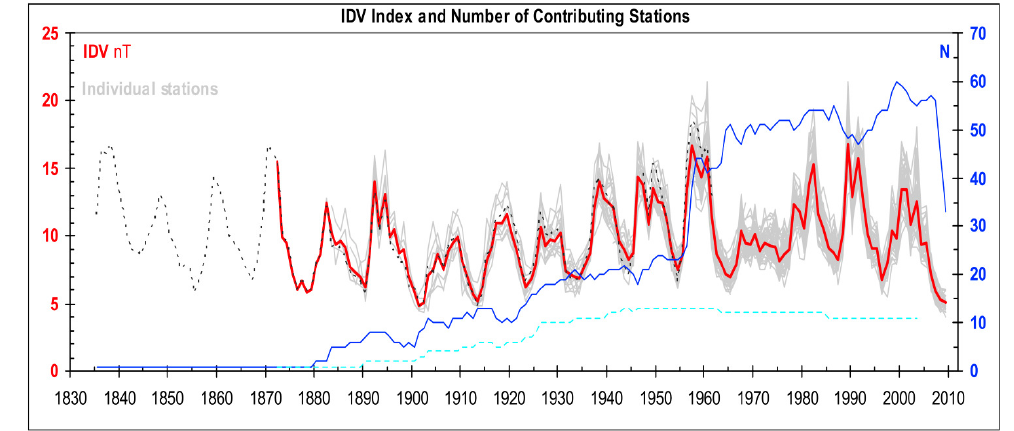
Figure 7: Annual means of the 𝐼𝐷𝑉 index compiled by Svalgaard and Cliver (2010). The grey curves are the variations for individual stations. The red curve is the index, defined as the arithmetic mean of the median and average values of the individual station values. A few station values were very large outliers of the distribution at any one time and those that were more than five standard deviations from the average were omitted in calculating the 𝐼𝐷𝑉 value for that year. The number of contributing stations, 𝑁 , is shown by the thin blue curve. The dashed blue line is the corresponding number of stations used by Svalgaard and Cliver (2005). Bartels’ 𝑢 index is considered a single station and gives the dotted line extension to before 1871 using a linear regression of 1871 – 1930 data with the 𝐼𝐷𝑉 index proper. Image reproduced by permission from Svalgaard and Cliver (2010), copyright by